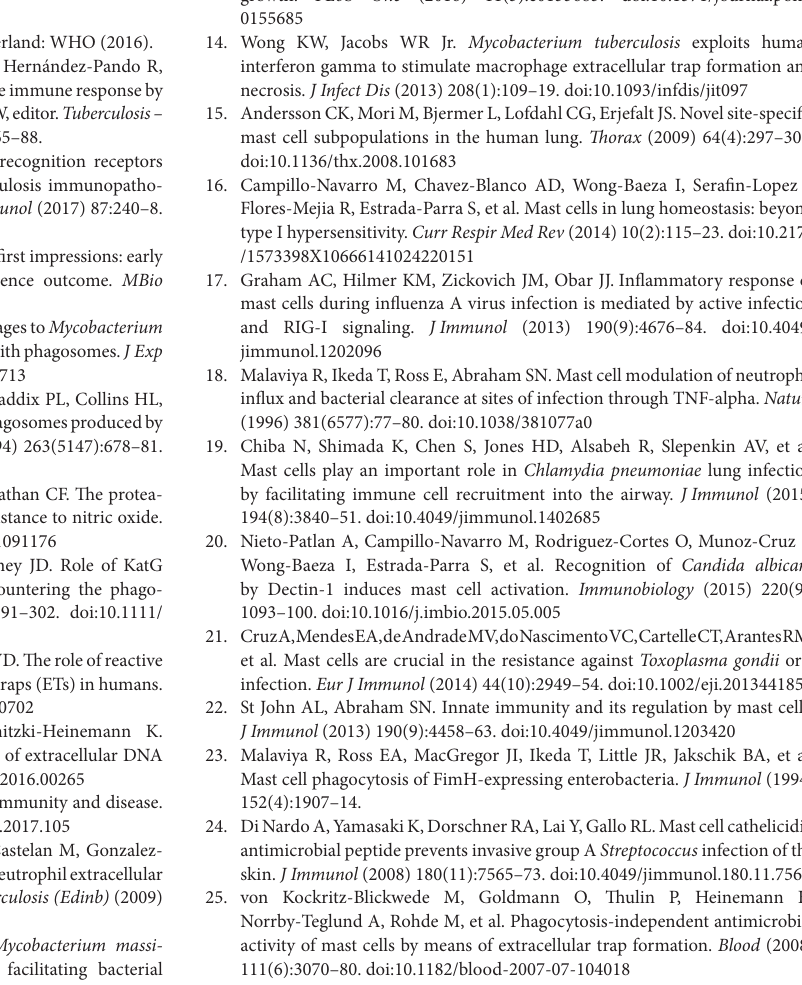
FigUre s1 | Bone marrow-derived mast cell purity. (a) Representative flow cytometry density plot of bone marrow cells after 6 weeks of culture with IL-3 and SCF. The percentage of Fc ε RI + CD117 + cells is shown. (B) BMMC were stained with toluidine blue and analyzed by light microscopy (magnification 1,000 ×